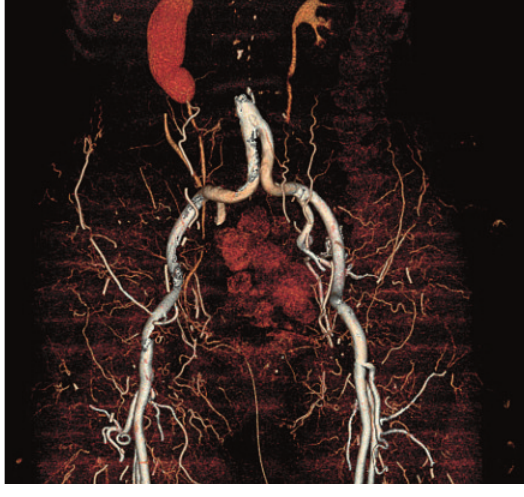
Figure 2 Coronal Volume Rendered (VR) image displaying very tortu- ous iliofemoral systems bilaterally,